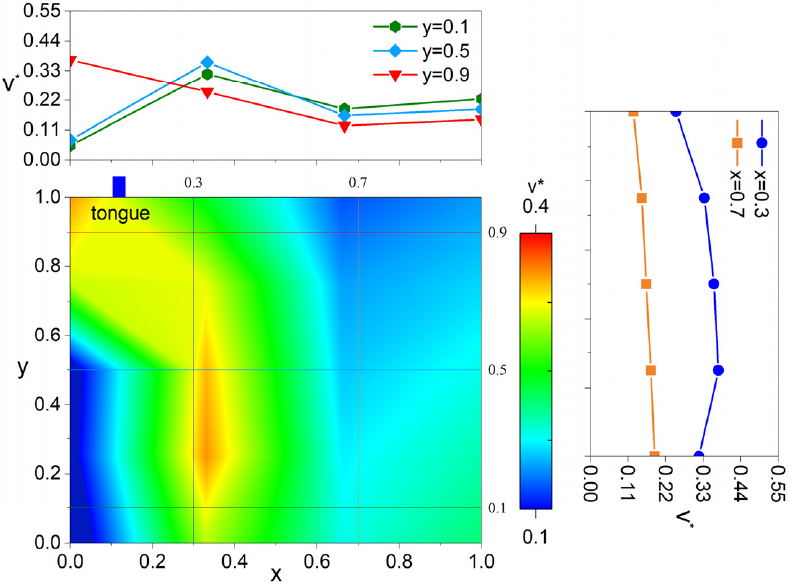
Figure 14. Reconstruction of the flow field around the volute tongue region under 0.8 Φ N .